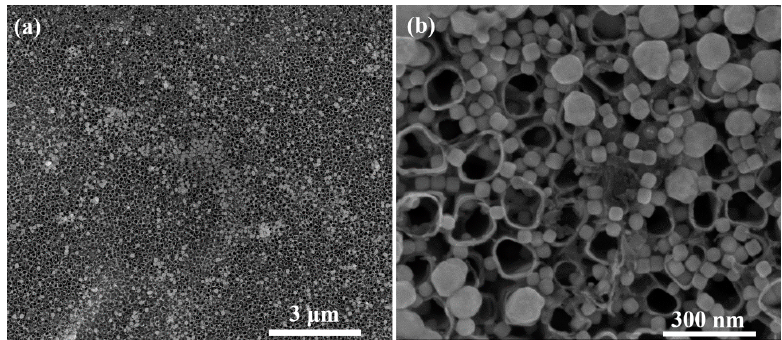
Figure 7. SEM image of Ag cubic nanoparticles deposited by droplet method on titanium oxide nanotubes at low ( a ) and high magnification ( b ). nanotubes at low ( a ) and high magnification ( b